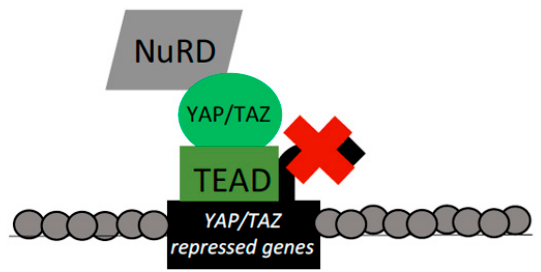
Figure 5. YAP / TAZ / TEAD interactions with the NuRD complex. YAP / TAZ–TEAD bind targets and recruit the NuRD complex to repress target expression. This repression is mediated through dual ATP-dependent chromatin remodeling and histone deacetylase (HDAC)-mediated histone deacetylase functions of the NuRD complex to ultimately reduce chromatin accessibility. YAP / TAZ targets repressed by NuRD recruitment included genes that drive apoptosis and promote senescence.